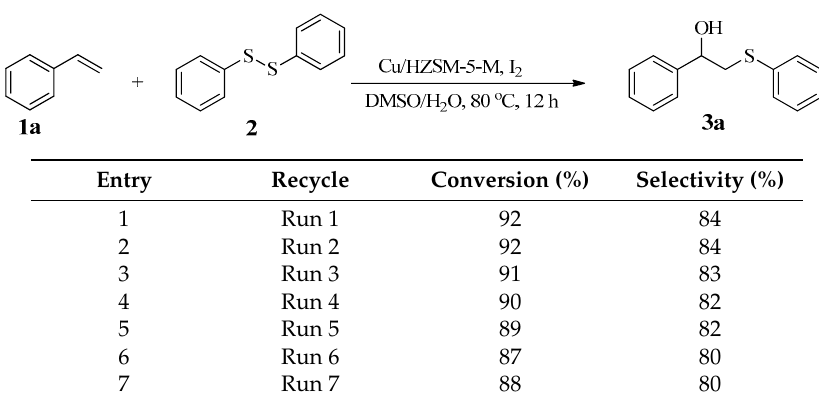
Table 4. The reusability of the catalyst 1 .